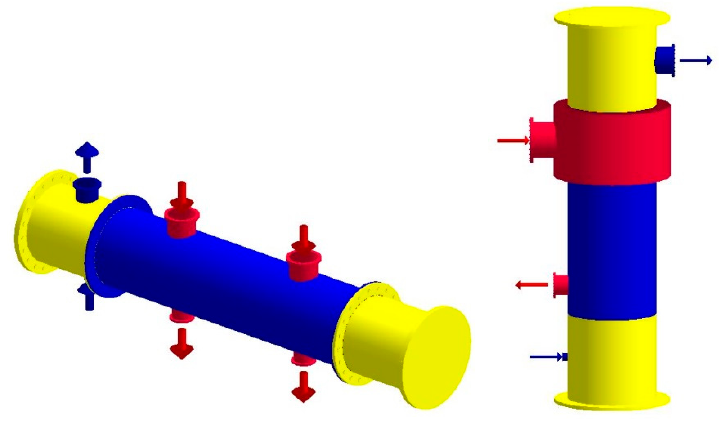
Figure 1. Previous horizontal design ( left ) and improved vertical design ( right ).